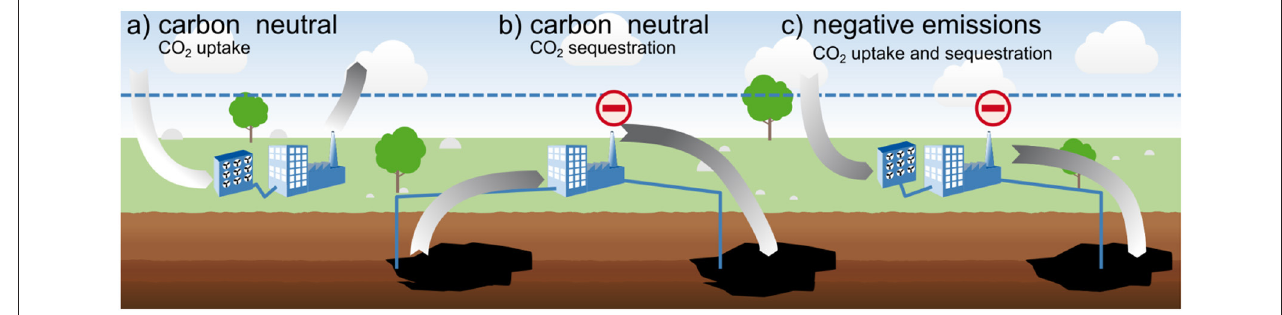
FIGURE 11 | (a) Carbon neutral CO 2 -uptake: CO 2 is taken from the atmosphere and is re-emitted after the product life cycle. (b) Carbon-neutral CO 2 sequestration: Fossil carbon is taken from underground reservoirs and CO 2 is sequestered after product life cycle. (a,b) are only carbon neutral if no emissions occur during the product life cycle. (c) Negative emissions: CO 2 is taken from the atmosphere and sequestered after the product life cycle. (c) will only have negative emissions if emissions over the entire lifecycle are < 1kg CO 2 -eq. per kg CO 2 up taken.